Question: Write a descriptive caption for this figure.
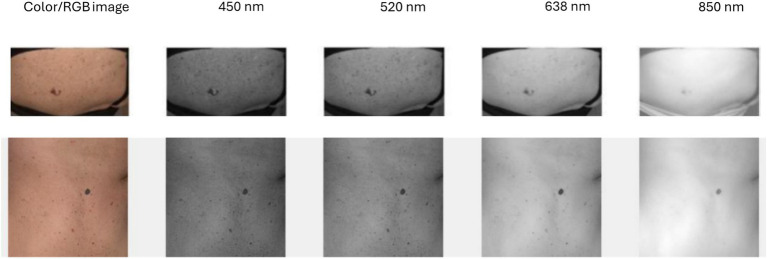
Answer: Comparison of spectral line images acquired from two cases of malignant melanoma surrounded by multiple nevi and photodamaged skin on the patients’ backs. While the visibility of the surrounding benign lesions progressively decreases with increasing wavelength, both melanomas remain clearly discernible in the 850 nm near-infrared image (NIR contrast persistence effect) ( 13 ).